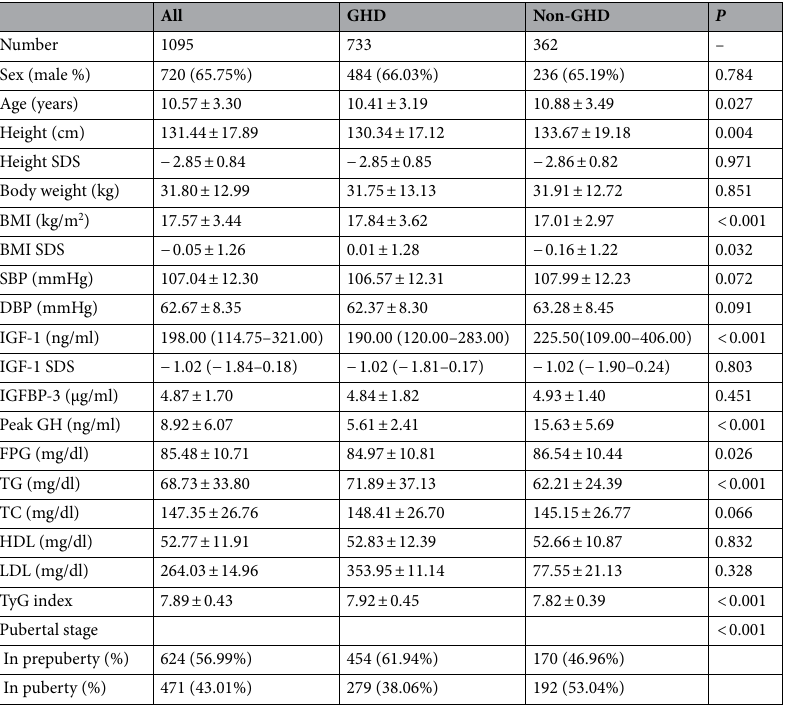
Table1. Clinical and biochemical characteristics. Abbreviations: Height SDS: height standard deviation scores; BMI SDS: body mass index standard deviation scores; IGF-1 SDS: insulin like growth factor-1 standard deviation scores; IGFBP-3: insulin-like growth factor-binding protein-3; Peak GH: peak growth hormone; FPG: fasting plasma glucose; TG: triglyceride; TC: total cholesterol. HDL-C: high density lipoprotein- cholesterol; LDL-C: low density lipoprotein cholesterol; TyG index: triglyceride glucose index. Normal distribution of data was presented as mean ± standard deviation; nonnormal distribution of data was presented as median (interquartile range) and categorical data using number (percentage). P < 0.05 is considered to be statistically